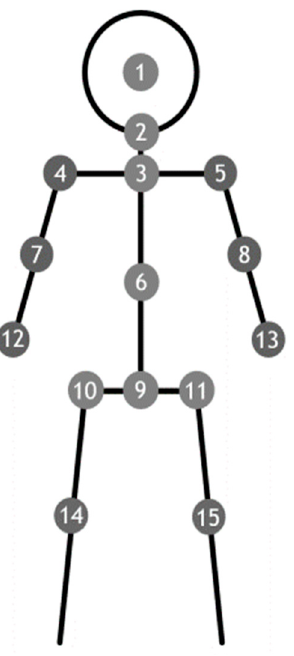
Figure 1. Signals from the 15 marked joints were measured using a kinetic depth sensor. (1) Head, (2) neck, (3) shoulder center, (4) left shoulder, (5) right shoulder, (6) trunk center, (7) left elbow, (8) right elbow, (9) hip center, (10) left hip, (11) right hip, (12) left hand, (13) right hand, (14) left knee, and (15) right knee.